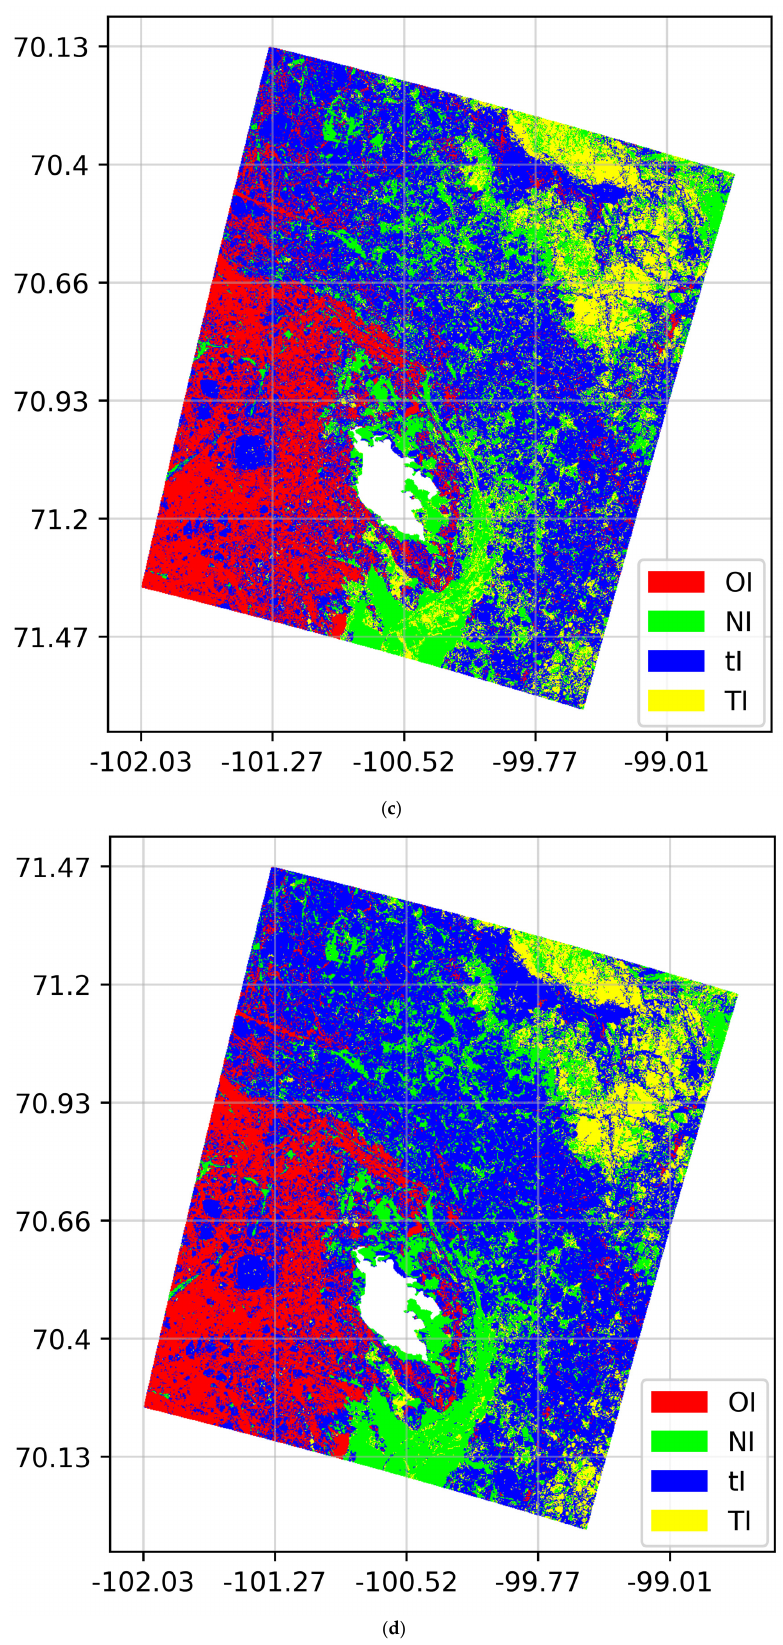
Figure 11. Sea ice classification results for ( a ) scene 19 using ( b ) SCNN, ( c ) ResNet18, and ( d ) proposed method. Table 6. Sea ice classification confusion matrix using three classification algorithms in three regions.